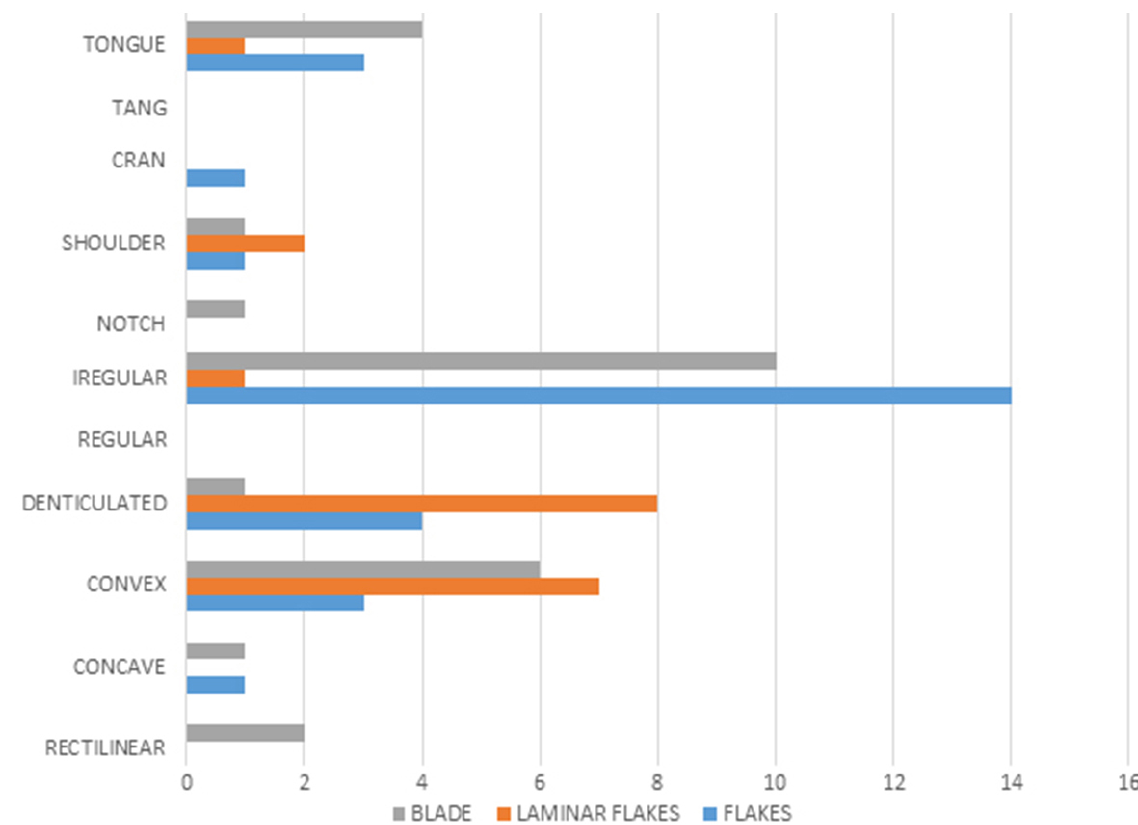
Figure 9. Representation of the type of delineation of the retouch.